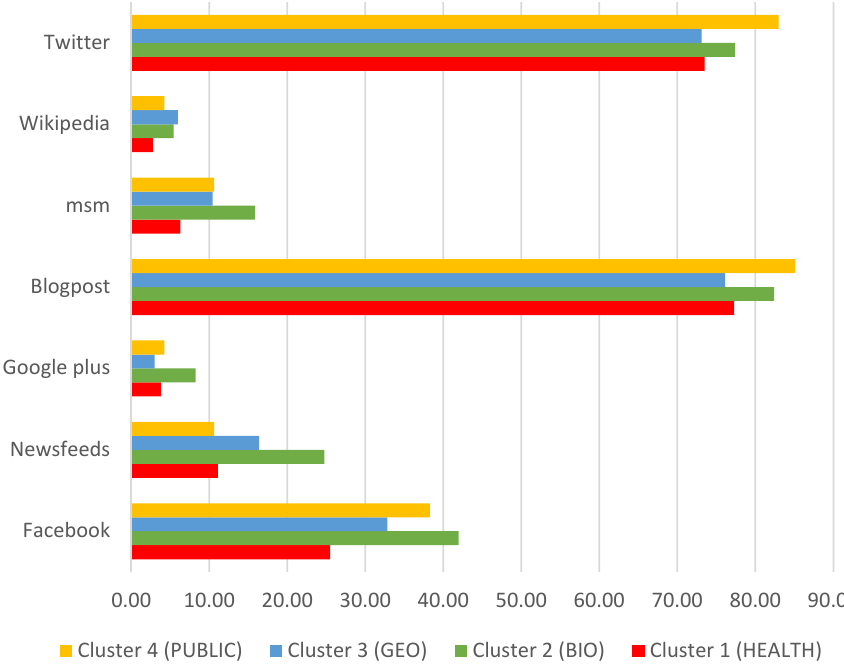
Figure 10. Percentage of open access documents with mentions by social network.